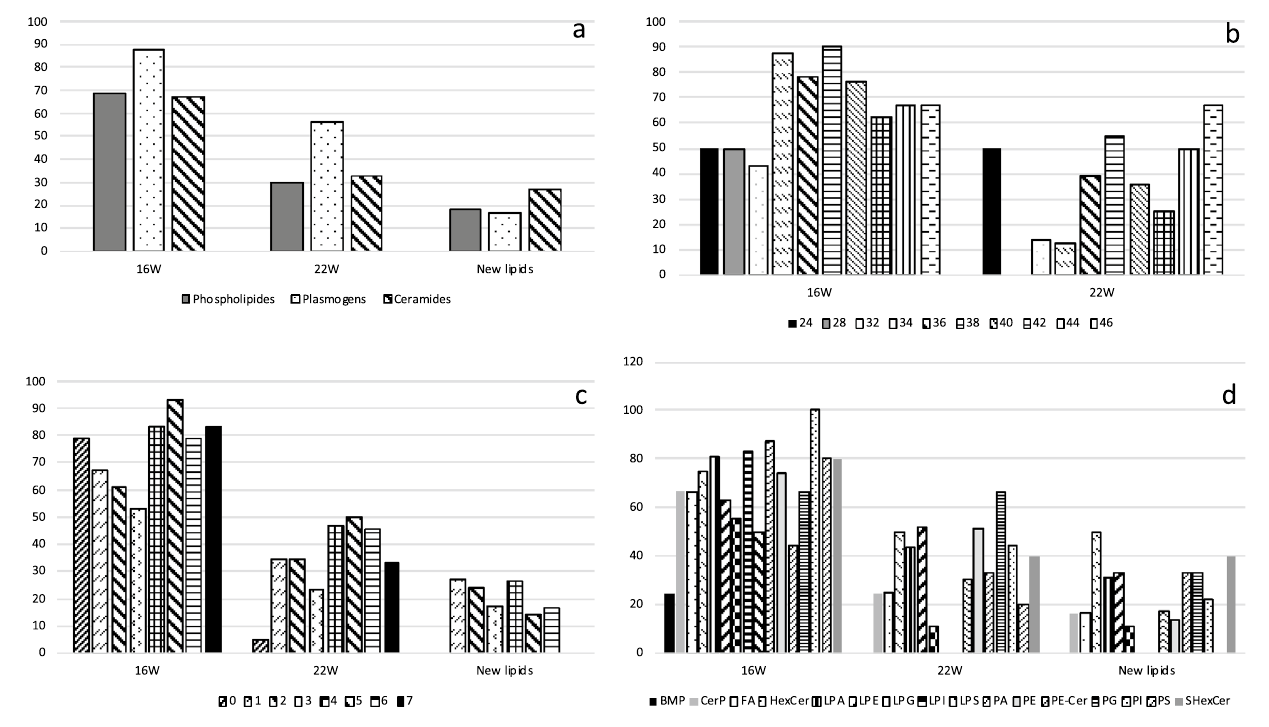
Figure 8. Lipid’s relative abundance variations sorted by (a) the lipid’s type (phospholipids, ether lipids and ceramides), (b) the carbon chain length, (c) the number of unsaturation and (d) lipid species at 16 and 23